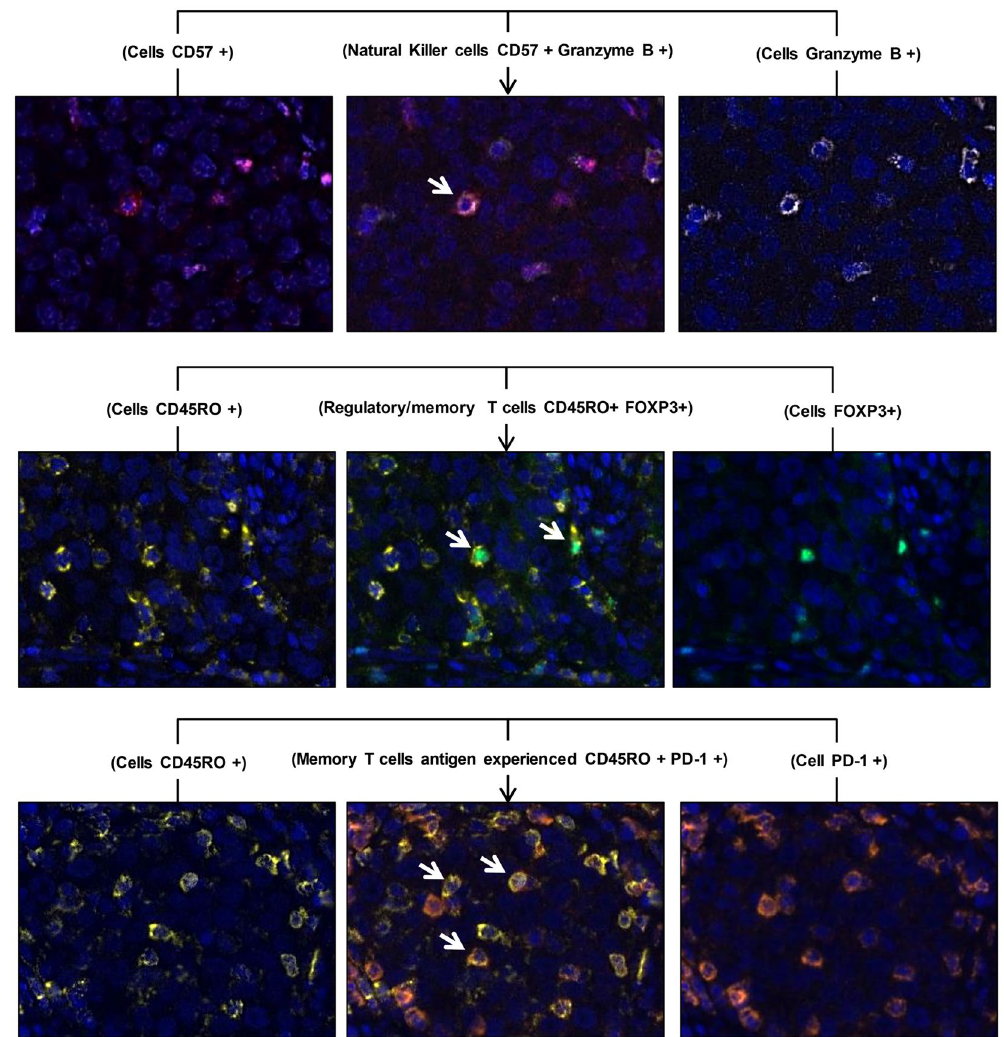
Figure 5. Microphotographs of representative examples of co-localization of the cell markers observed in panel